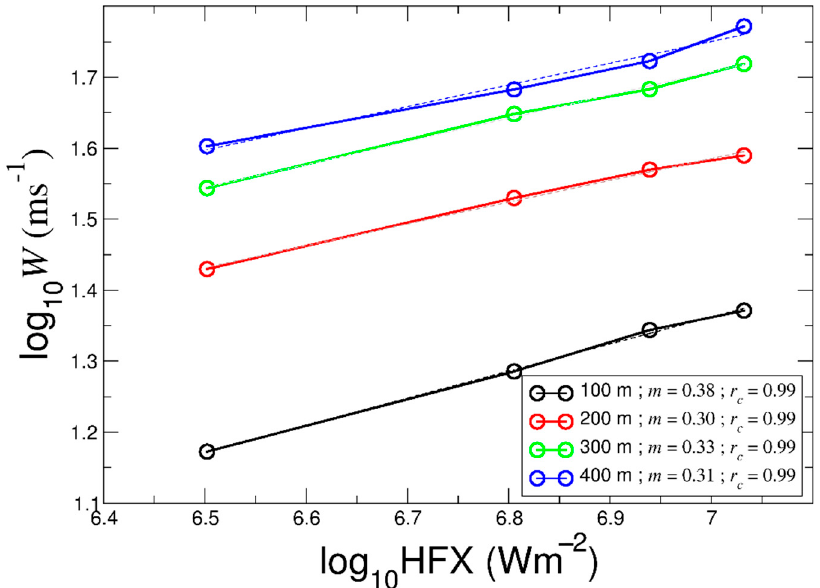
Figure 3. Maximum vertical velocities within the plume, W , at several heights above ground level for increasing surface heat flux, HFX . The best linear fit (denote by dashed lines, with gradient m and correlation coe ffi cient r c ) is also shown for each group of